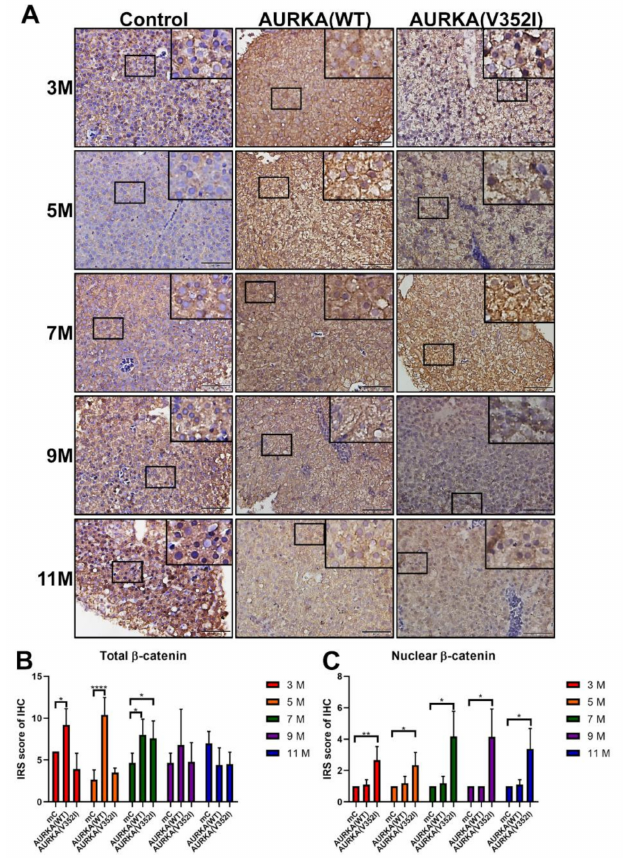
Figure 8. Immunoreactive score of immunohistochemistry for β -catenin reveals that AURKA(V352I) is significantly lower than control and AURKA(WT) at 3, 5, and 7 months. ( A ) Representative images of immunohistochemistry (IHC) staining for β -catenin in control, AURKA(WT) and AURKA(V352I) at 3, 5, 7, 9, and 11 months; ( B ) Statistical analysis of β -catenin immunostaining IRS score at 3, 5, 7, 9, and 11 months; ( C ) Statistical analysis of nuclear β -catenin immunostaining IRS score at 3, 5, 7, 9, and 11 months. IRS score of control fish (Tg(fabp10a:EGFP-mCherry) abbreviated as mC, AURKA(WT) and AURKA(V352I) is shown in red (3 M), orange (5 M), green (7 M), purple (9 M), and blue (11 M). Statistical analysis of results was performed using a two-tailed Student’s t -test. The error bar means standard deviation. Asterisks (*) represent the level of significance. * p -value ≤ 0.05; ** p -value ≤ 0.01; *** p -value ≤